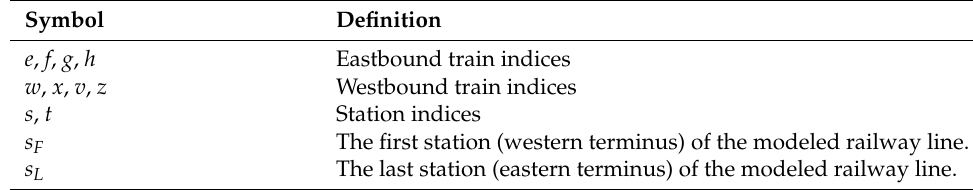
Table 2. Indices and other symbols.